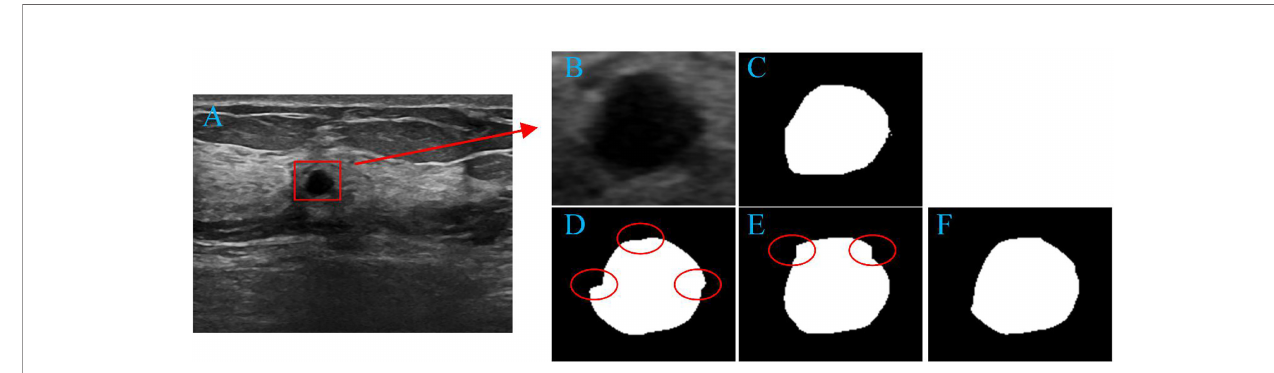
FIGURE 9 | Tumor segmentation results. (A) original image, (B) tumor area, (C) the ground truth of tumor area, (D) the result of PropMeth_1, (E) the result of PropMeth_2, (F) the result of PropMeth_3.